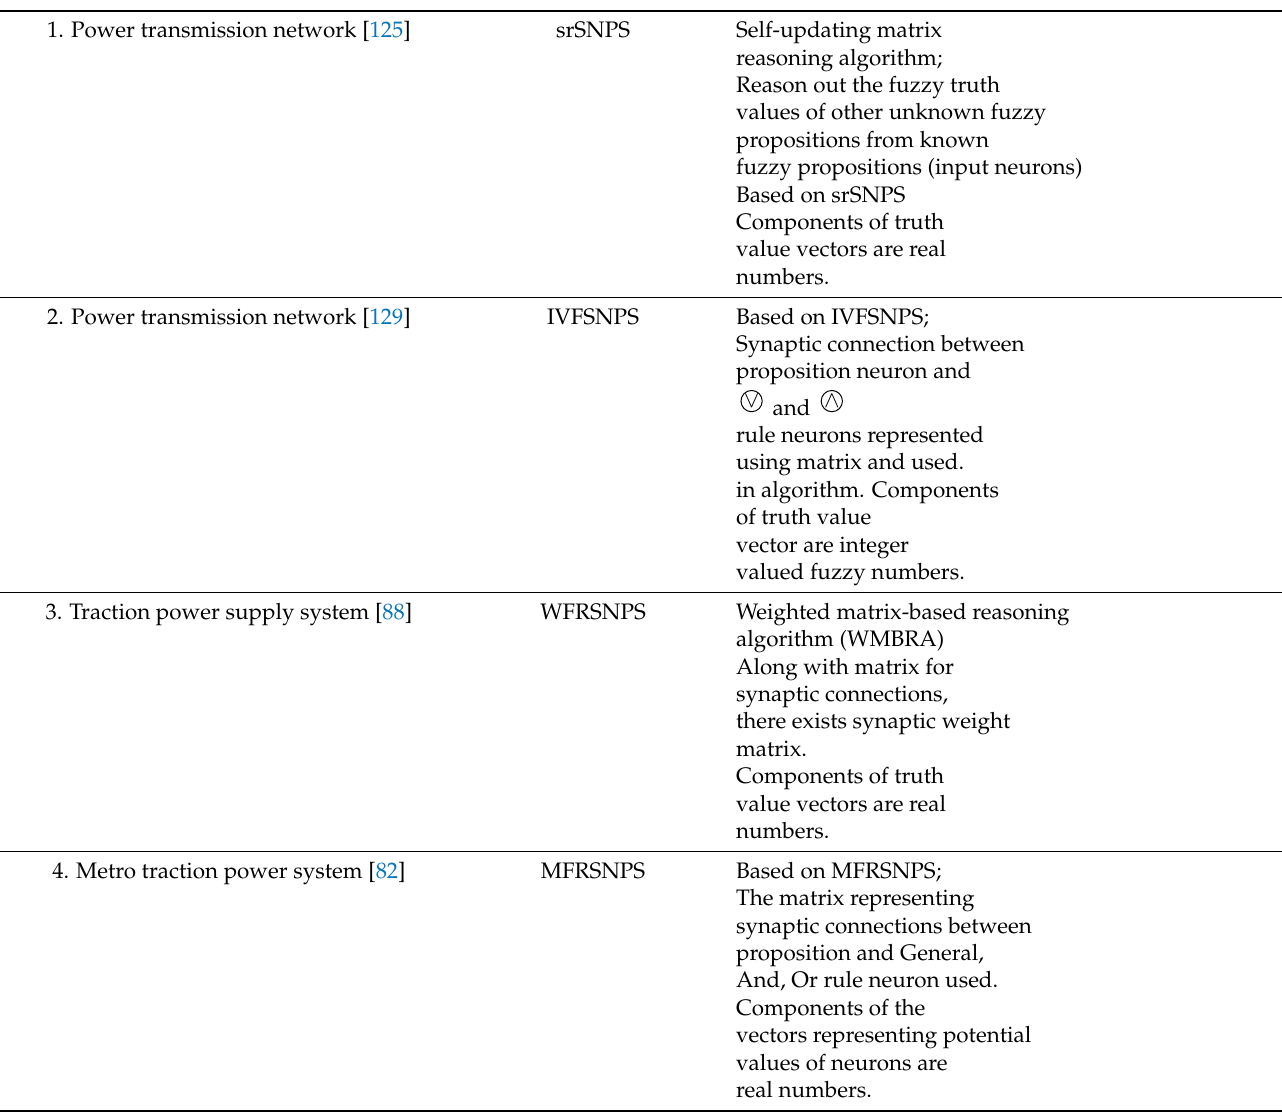
Table 8. Comparisons of reasoning algorithms for transmission